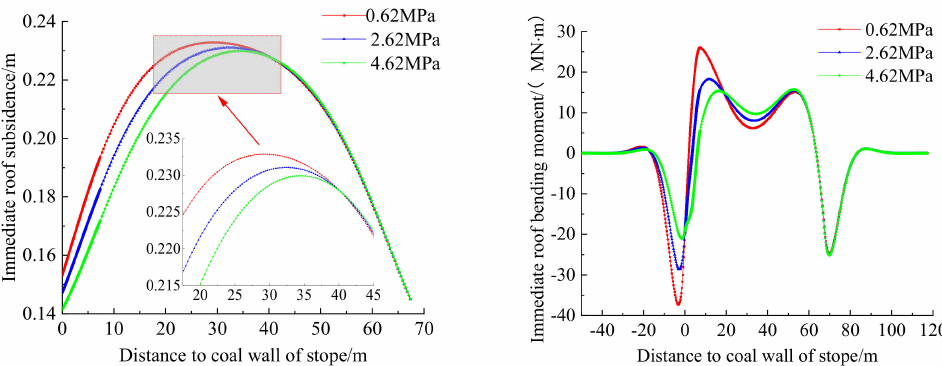
Figure 4. Relationship among supporting-peak loads, roof subsidence, and bending